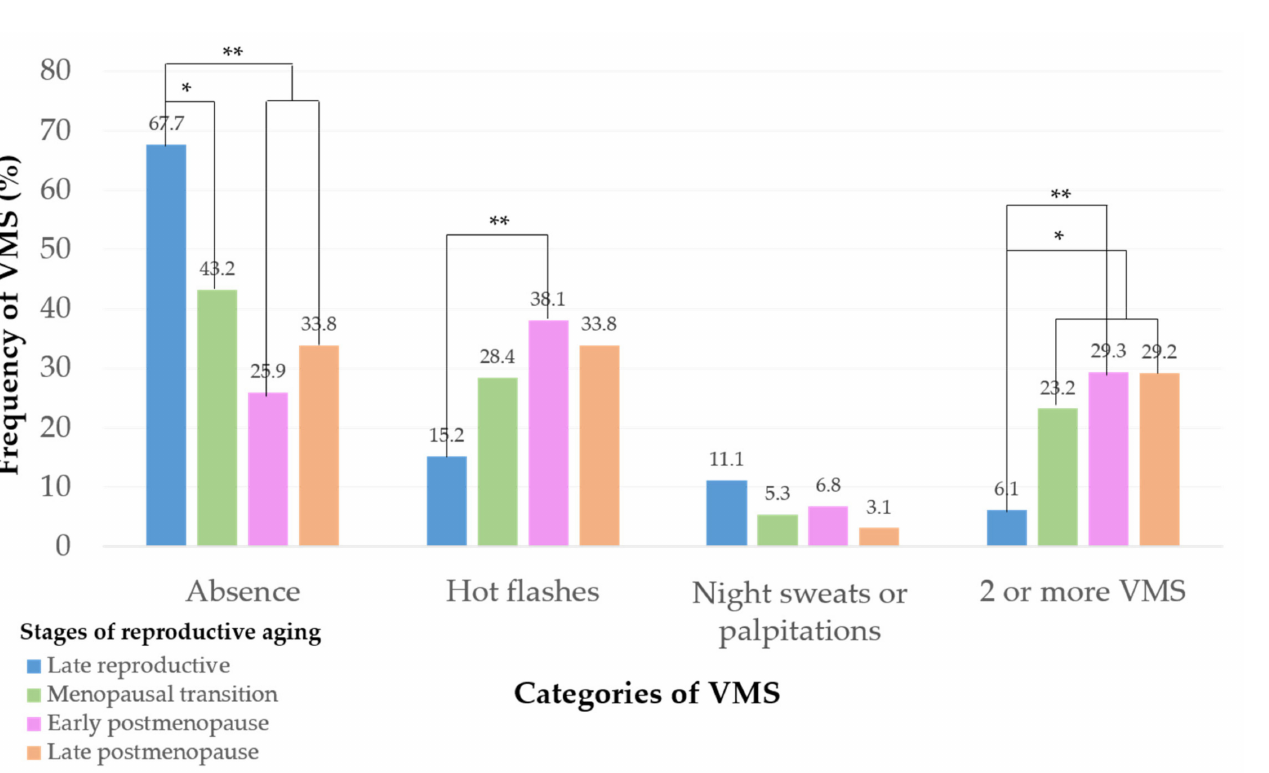
Figure 2. Prevalence of vasomotor symptoms. Data were analyzed using a chi-square test with the Marascuilo procedure (post hoc test). They are expressed as percentages (%). * p < 0.01, ** p <